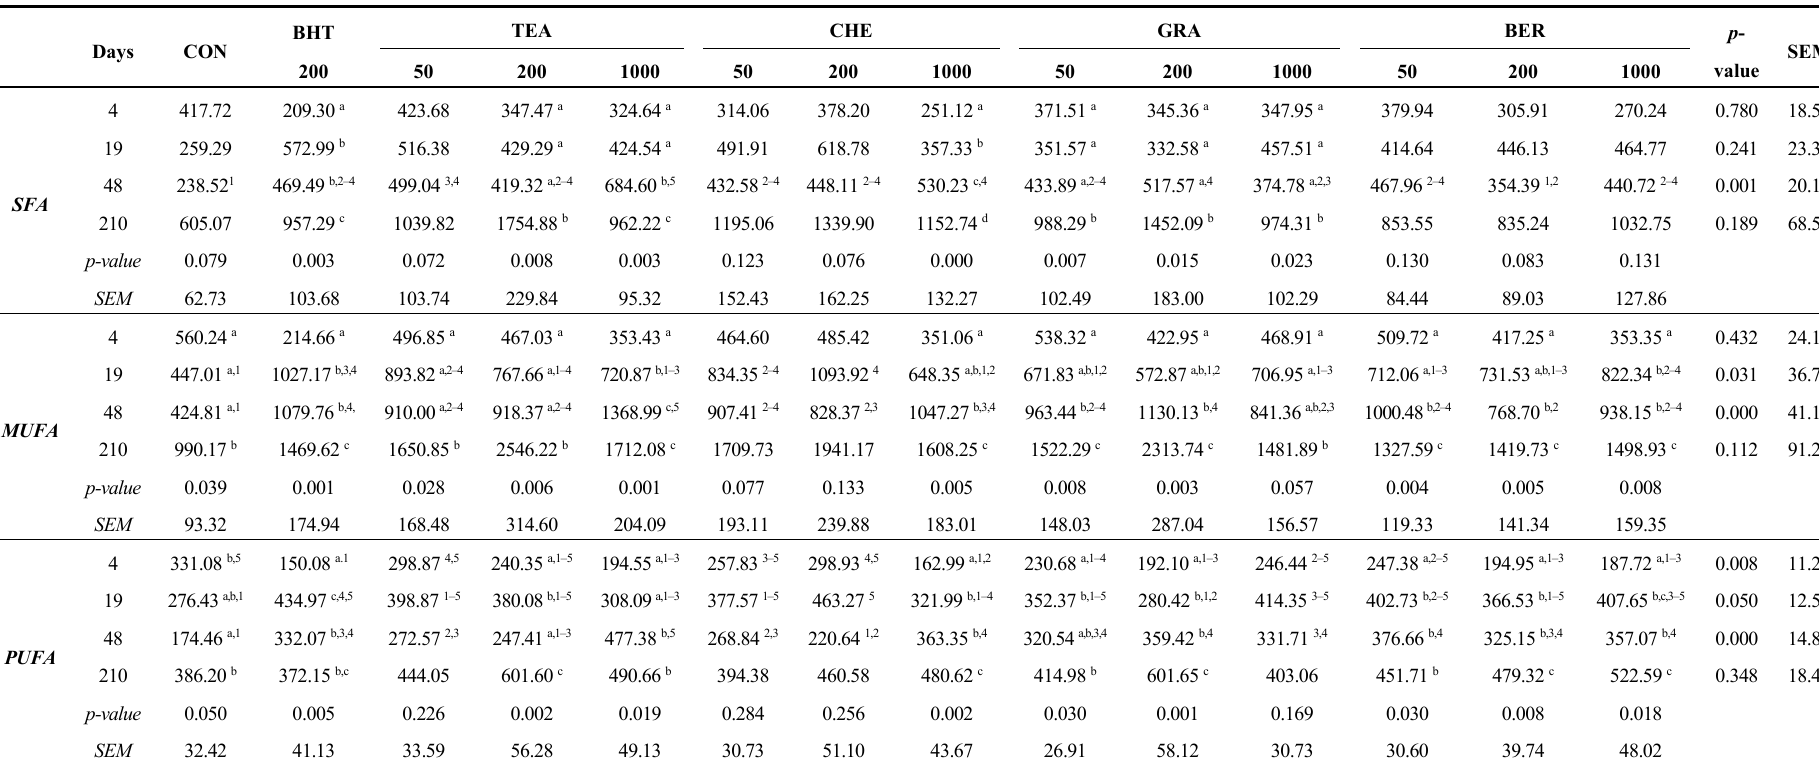
Table 5. Evolution of main nutritional index (mg/100g) of “chorizo” treated with BHT and natural antioxidants during ripening and